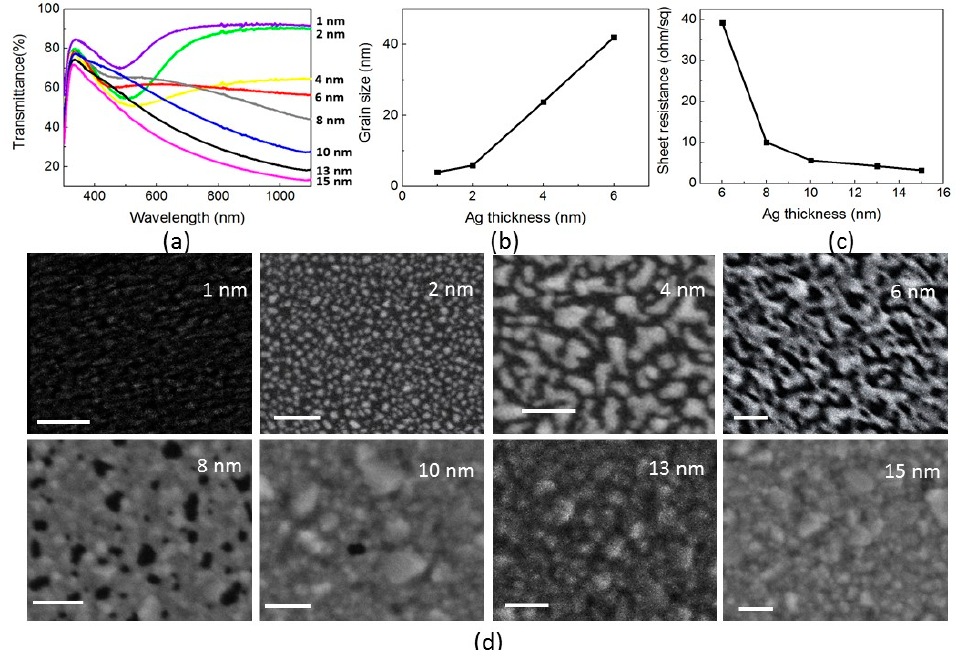
Figure 3. ( a ) Optical transmittance spectra of Ag thin films with thickness from 1 to 15 nm. ( b ) Dependence of Ag thickness on its grain size. ( c ) Dependence of Ag thickness on its sheet resistance. ( d ) SEM micrographs of the morphology of the Ag thin films.